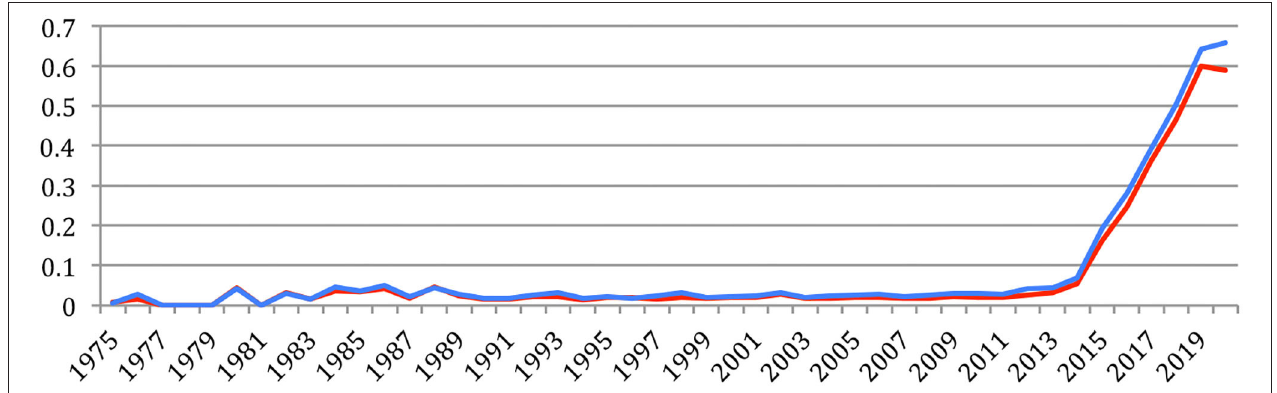
FIGURE 47 | Percentages of authors (blue) and of papers (red) mentioning “Embedding” in speech and NLP (% of all papers).